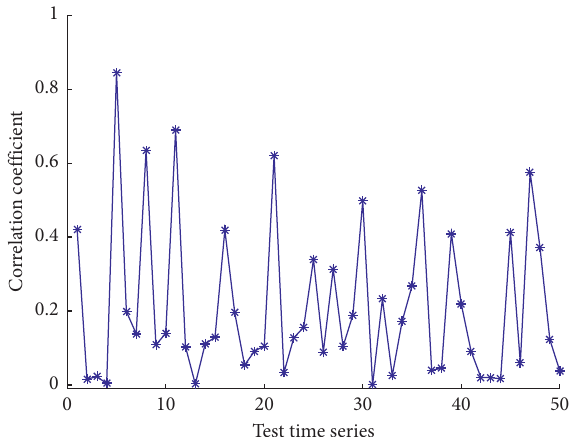
Figure 7: Line graph of change of correlation coefficient of unit speed with